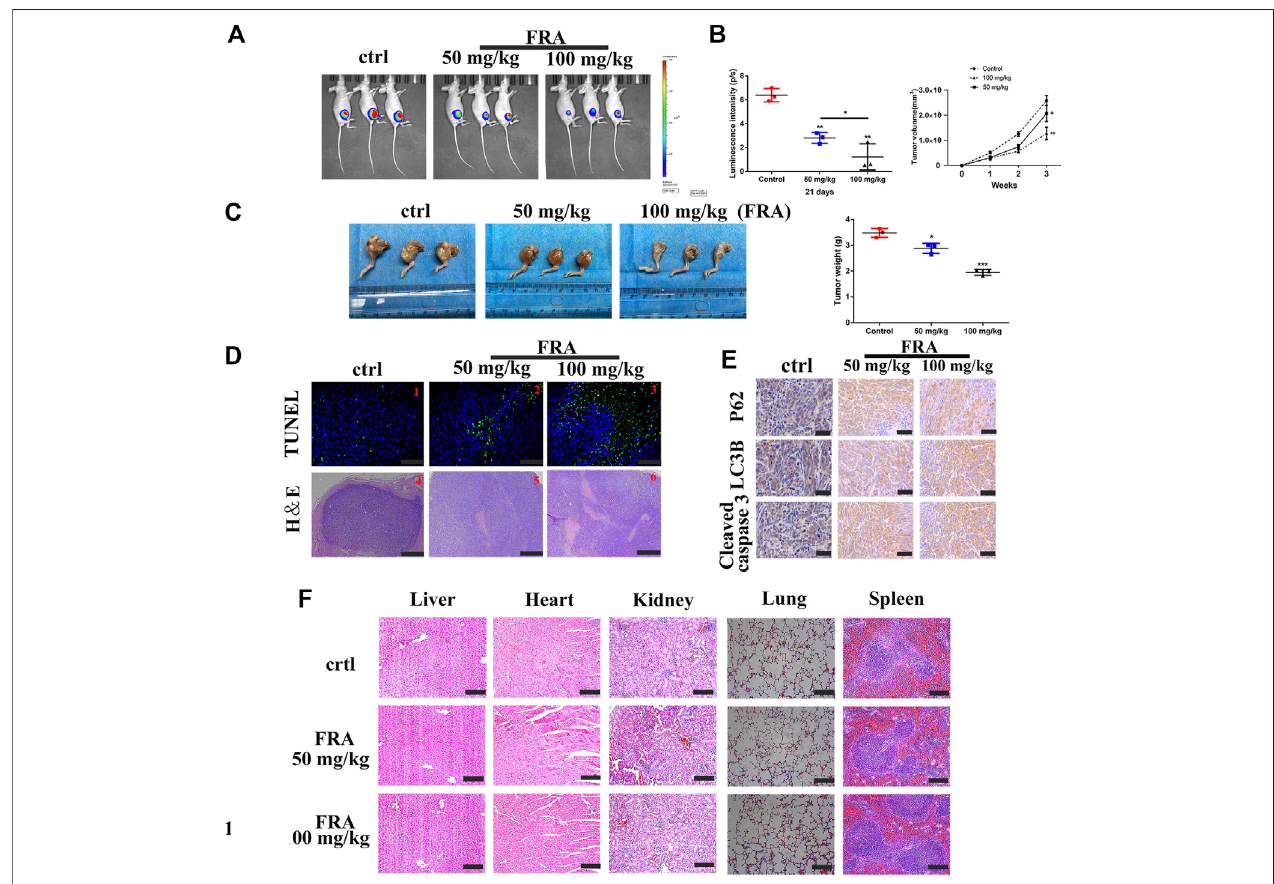
FIGURE5 | FRA hindersosteosarcoma growth in vivo . (A) After 21 days ofFRA treatment, luciferase intensity oftumor wasmeasuredand calculated by an invivo imaging system. (B) The luciferase intensity of tumor was analyzed. The curves of tumor volume showed a signi fi cant difference among the groups after 3 weeks administration of FRA. (C) The photographs show that there was a signi fi cant difference in tumor weights between the three groups after 21 days. (D) TUNEL assays wereusedtomeasuretheapoptoticstatusoftumortissues.FRApromotedextensivetumorcellnecrosiswasprovedbyH&Estaining. (E) ThelevelsofLC3B,P62 and cleaved-caspase 3 were further examined by immunohistochemistry. (F) The vital organs of mice (including the heart, liver, spleen, lungs and kidneys) did not show signi fi cant toxicity throughout the experimental. Error bar (cid:2) mean ± SEM. Magni fi cation, × 200 (D1 – 3), × 40 (D4-6), × 400 (E) . Scale bar, 100 μ m (D1-3), 500 μ m (D4 –